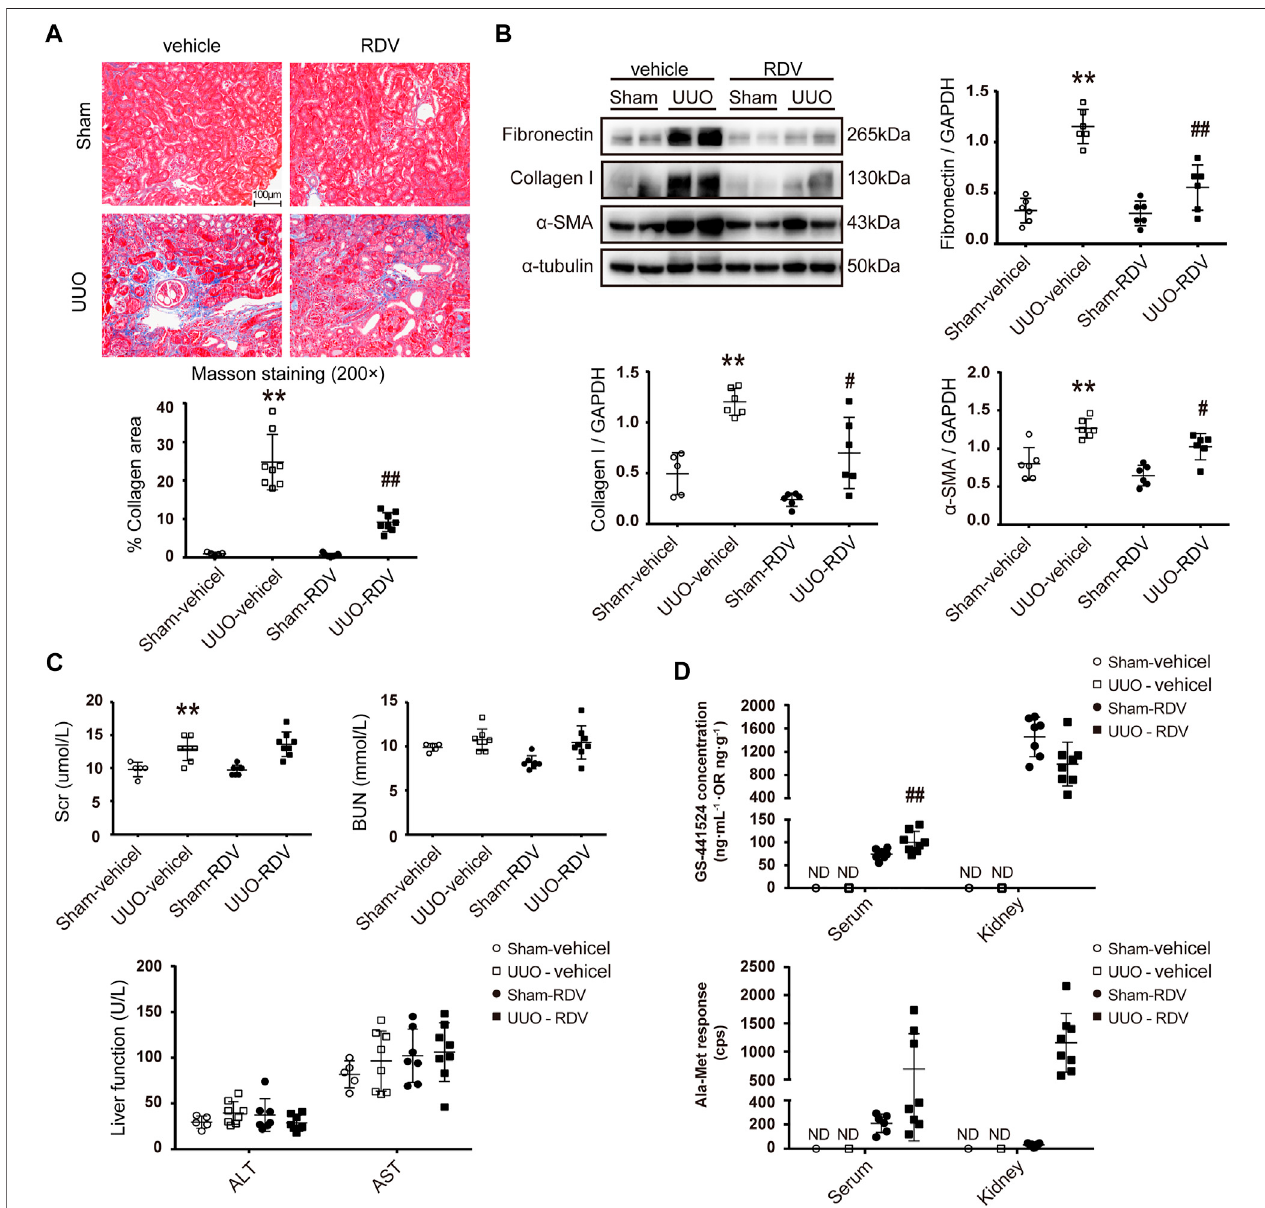
FIGURE 2 | Intraperitoneal (i.p.) administration ofRDVinhibited fi brosisin UUO mice.After shamor UUO operation, wide type c57 miceweretreated with 10 mg/kg/d RDV by i.p. injection for 10 days. Serum and kidney tissues were collected 1 h after RDV injection at day 10 (A) Renal fi brosis was assessed by Masson ’ s trichrome staining, and then was quanti fi ed (B) The expression of FN, collagen I (Col-1) and α -SMA were analyzed by Western blotting. One representative of at least three independent experiments is shown (C) Renal function (Scr and BUN) and liver function (ALT and AST) were assessed (D) The concentrations of nucleoside metabolite (GS) and alanine metabolite (Ala-Met), two RDV metabolites, in serum and kidneys were determined by LC-MS/MS. Data represent mean ± SD. ND represents not determined. ** p < 0.01 vs. Sham-vehicle; # p < 0.05 vs. UUO-vehicle; ## p < 0.01 vs. UUO-vehicle.